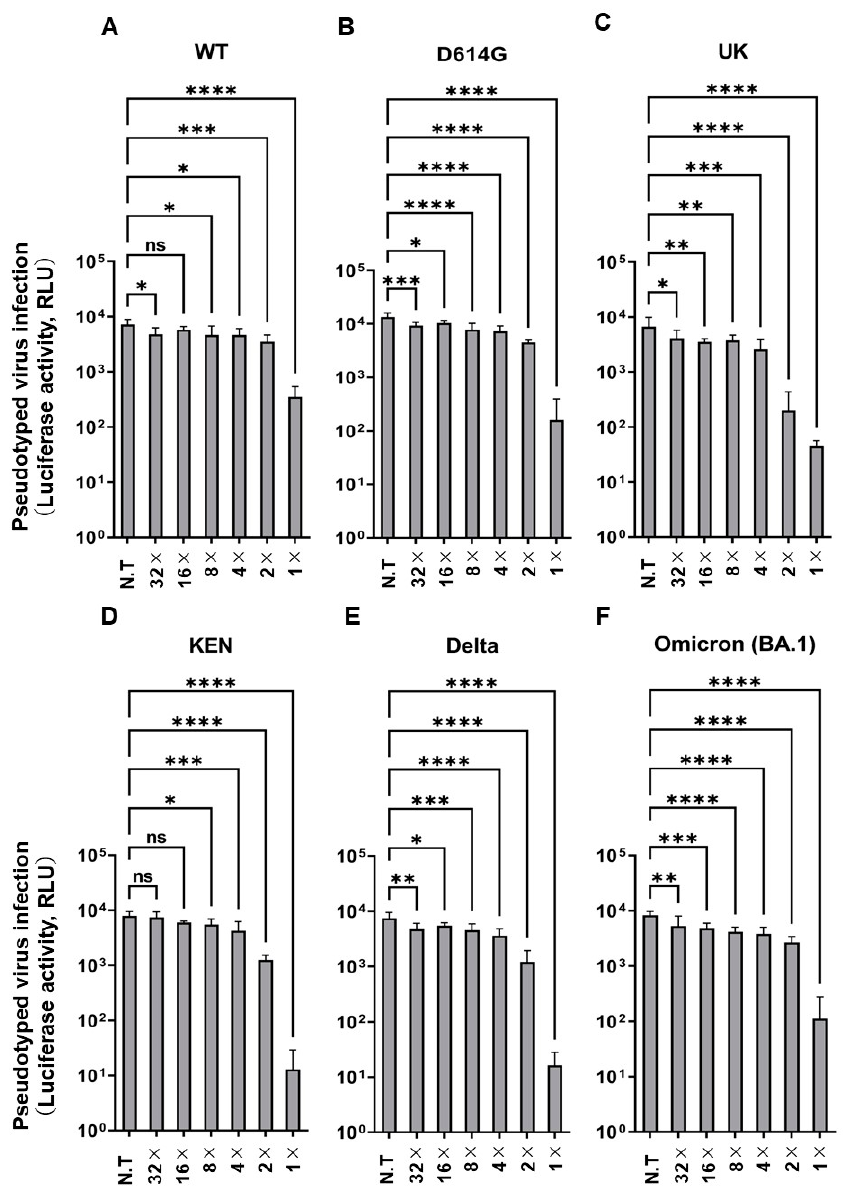
Figure 1. PAA impaired pseudotyped SARS-CoV-2 infection. Dose-dependent inactivation of pseu- dotyped SARS-CoV-2 by PAA in VeroE6/TMPRSS2 cells. The PAA dilution (1 × ) was prepared to